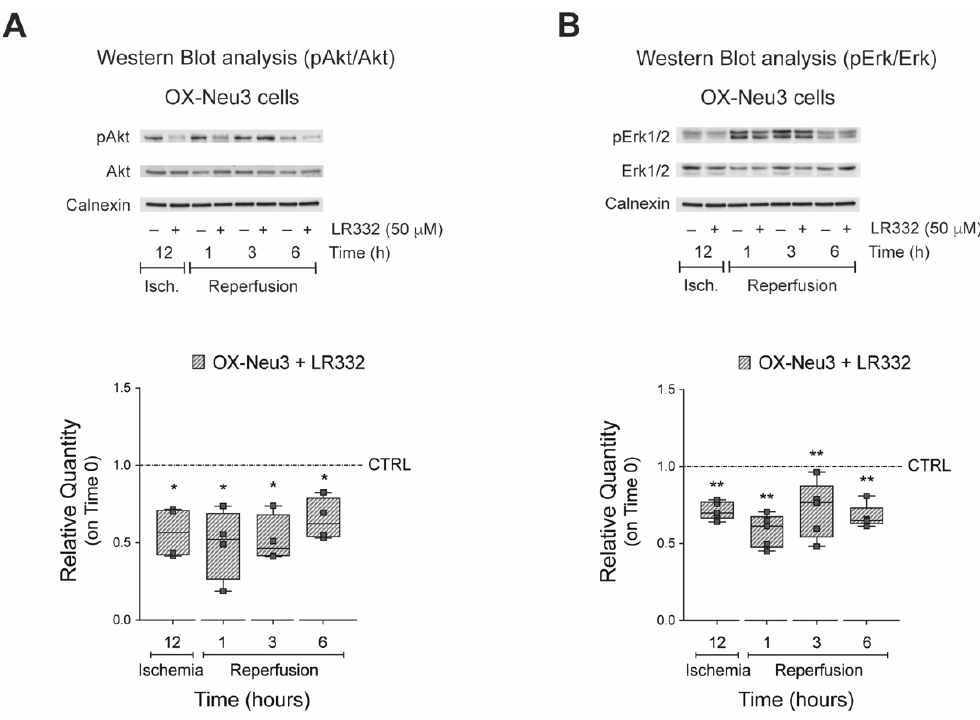
Figure 7. Effects of sialidase-3 inhibition on activation of the RISK pathway . Activation of Akt and Erk1/2 in OX-Neu3 H9c2 treated with LR332 (arbitrary name given to the non-commercially available sialidase3 inhibitor synthesized by our group) was examined by WB. ( A ) WB analysis of phospho-Akt (Thr308) and total-Akt (upper panel); ratio between phospho-Akt (Thr308) and total-Akt (lower panel); ( B ) WB analysis of phospho-Erk1/2 (Thr202/Tyr204) and total-Erk1/2 (upper panel); ratio between phospho-Erk1/2 (Thr202/Tyr204) and total-Erk1/2 (lower panel). Data are expressed as relative amounts compared with LR332 untreated OX-Neu3 cells exposed to IRI in vitro ( CTRL dashed line ). Each square in the graphs represent an experimental replicate. Statistical significance was determined by the nonparametric Kruskal-Wallis test. * p < 0.05; ** p < 0.01.